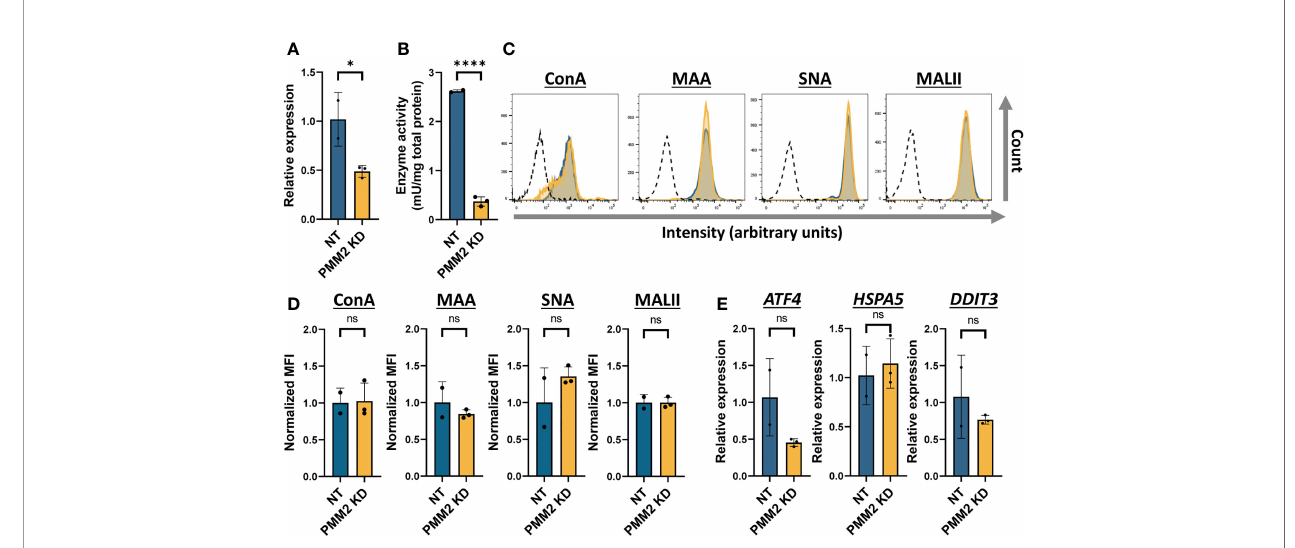
FIGURE 4 | shRNA-induced PMM2 knockdown as a model of PMM2-CDG (A) Quanti fi cation of the PMM2 RNA expression in THP-1 cells expressing non-targeting (NT, n = 2) or PMM2-targeting (PMM2 KD, n = 3) shRNAs. The mRNA expression level of PMM2 was measured by qRT-PCR and the data was normalized to ACTB and GAPDH expression. (B) The PMM2 enzyme activity in NT (n = 2) and PMM2 knockdown THP-1 cells (n = 3). (C) Histogram plots showing the intensity of fl uorescently labelled lectins (ConA, MAA, SNA and MALII) bound to THP-1 cells on a logarithmic scale. For simplicity, here we indicate only the unlabelled negative control (dotted line) related to sample NT as representative plot. (D) Quanti fi cation of the histogram plots showing the median fl uorescent intensity (MFI) normalized to the average MFI (set as 1) of the NT. Before normalization, the MFI values of the negative controls were subtracted. (E) Assessment of the ER stress response by measuring the RNA expression level of three ER stress components ATF4, HSPA5 and DDIT3 by qRT-PCR. The data was normalized to ACTB and GAPDH expression. Signi fi cance was calculated by an unpaired student ’ s t-test. Mean ± S.D., ns, non-signi fi cant, * ≤ p-value 0.05, **** ≤